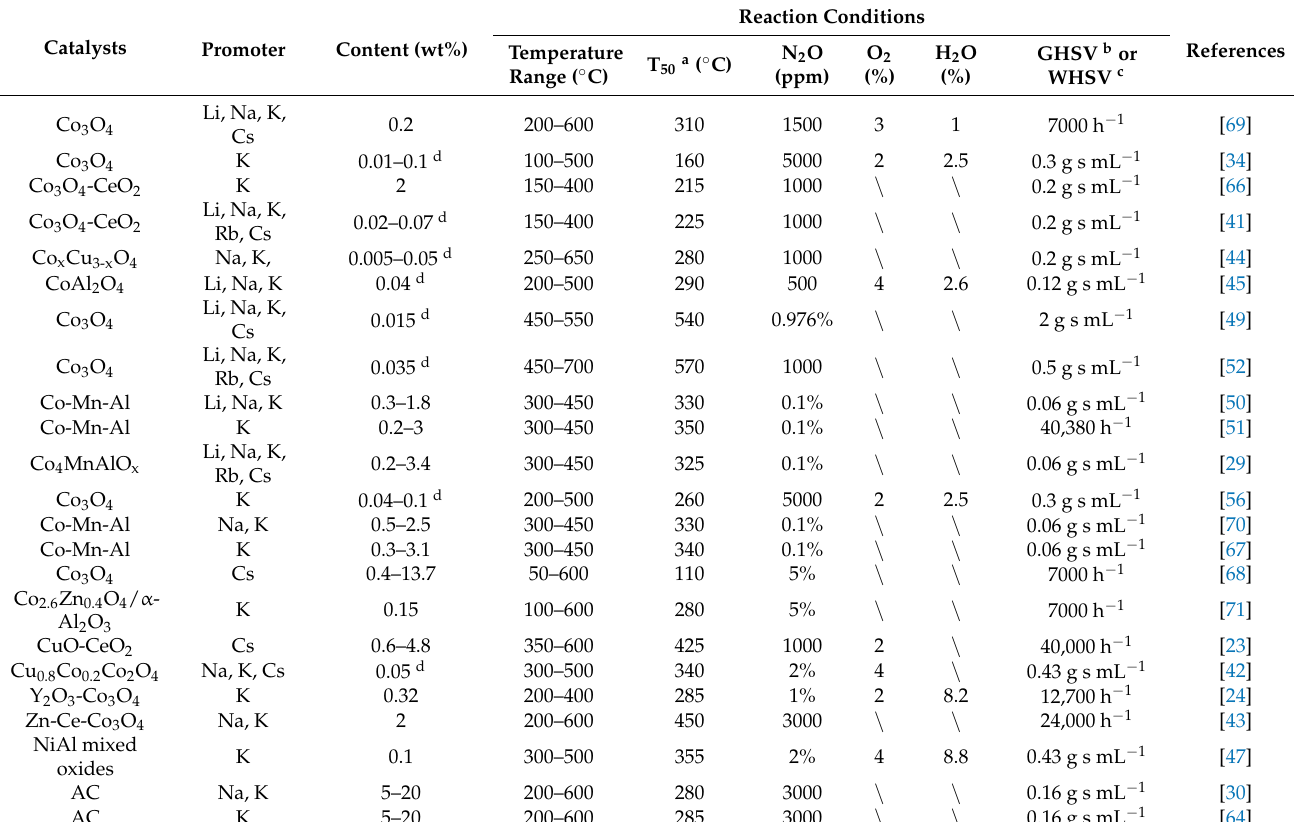
Table 2. Summary of catalysts and reaction conditions for N 2 O decomposition promoted by alkali